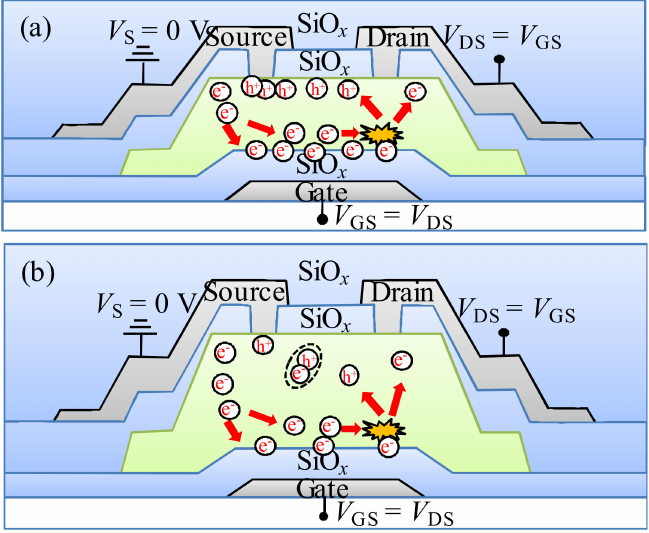
Figure 9. The schematic diagram of the mechanism of DCS-induced instability in the IGZO TFT with the T IGZO value of ( a ) 25 nm and ( b ) 45 nm, 75 nm, or 100